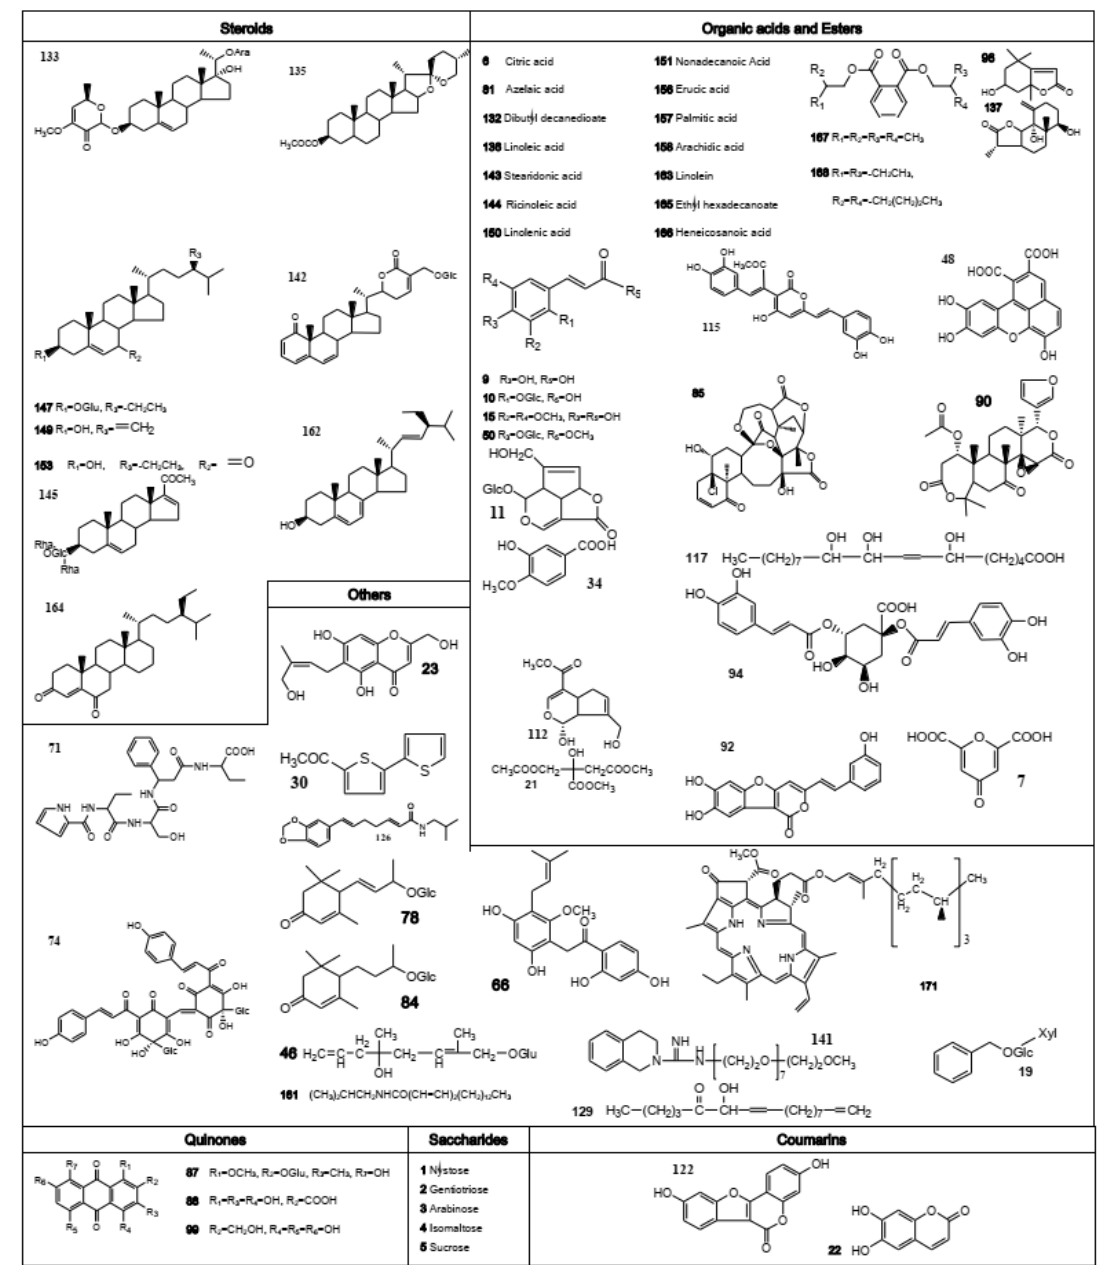
Figure 3. Chemical structures of compounds identified in six different parts of lotus.